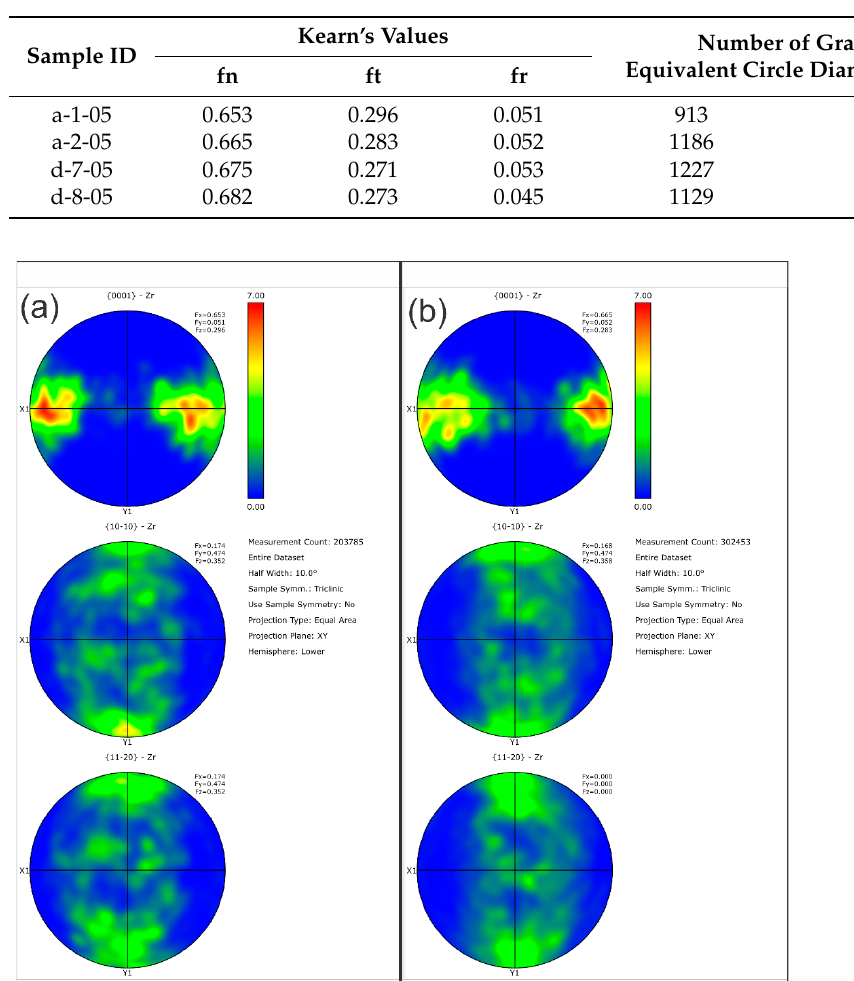
Figure 13. Depth profile for pretreated and activated d-sample showing decrease of NiO with depth. Table 5. Summary of measured Kearn’s values for the four NPG samples.